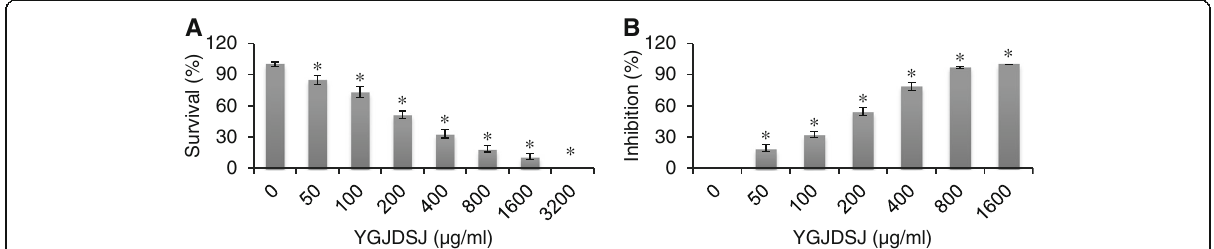
Fig. 1 YGJDSJ inhibited anchorage-independent growth of Bel-7402 cells. a Bel-7402 cells were cultured in poly-HEMA coated 96-well plate and treated with different concentrations of YGJDSJ for 24 h, cell viability was evaluated by CCK-8 assay. b Bel-7402 cells were treated with different dose of YGJDSJ twice a week for 2 weeks in soft-agar colony formation assay. Data shown are representative of three independent experiments. * P < 0.01, versus control group